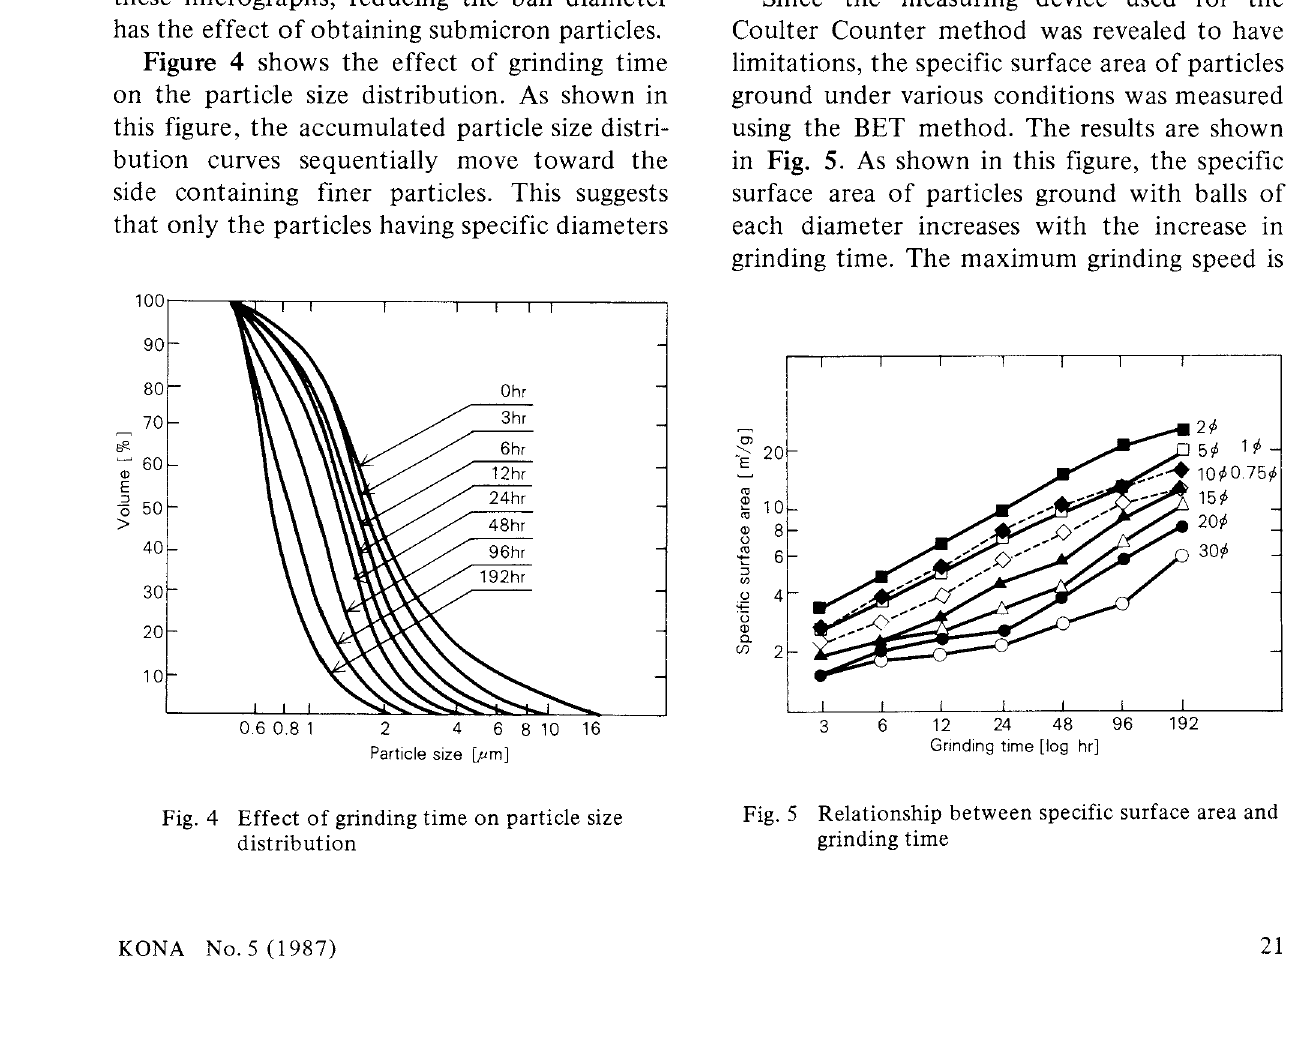
Fig. 5 Relationship between specific surface area and grinding